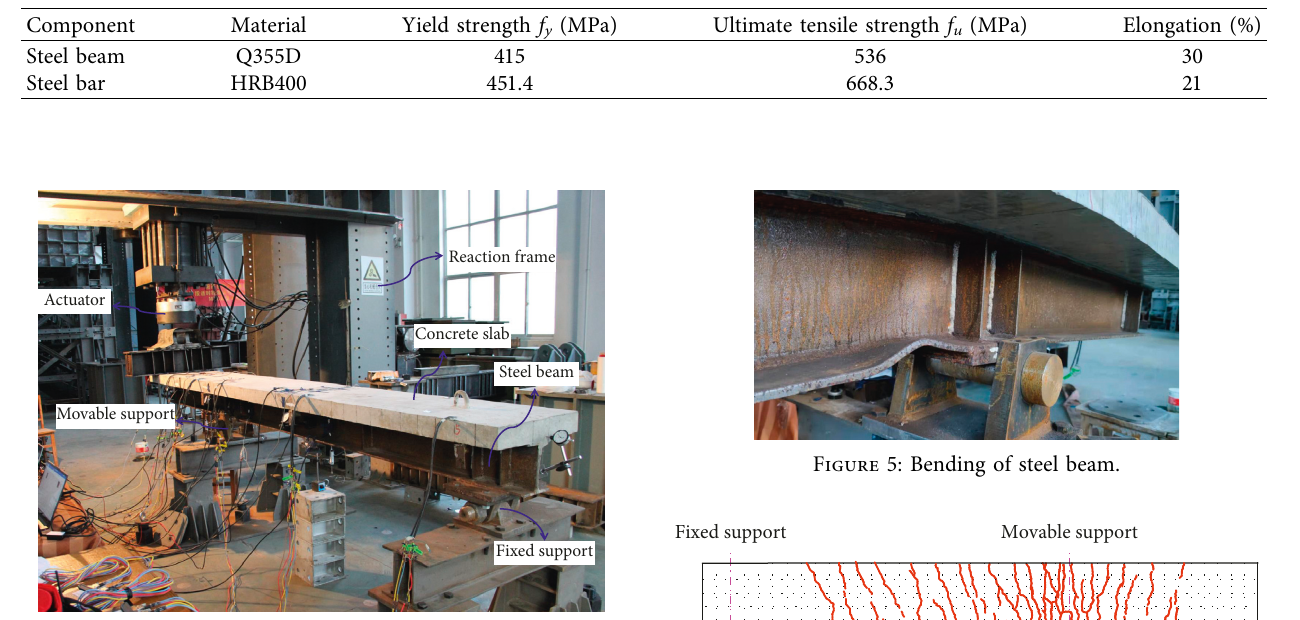
Table 2: Mechanical properties of the steel bar and steel beam.